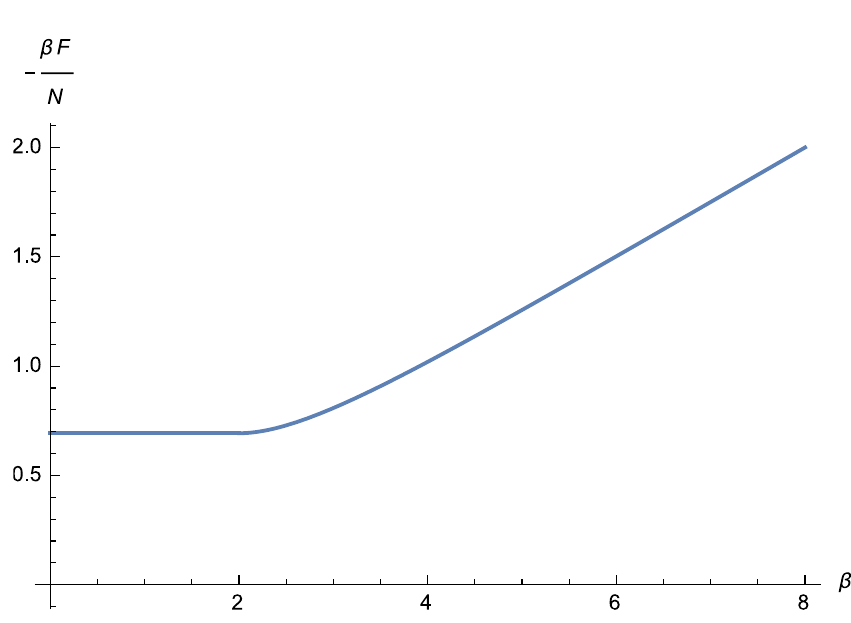
Figure 5 . Free energy per site at large N in the in(cid:12)nite range Heisenberg